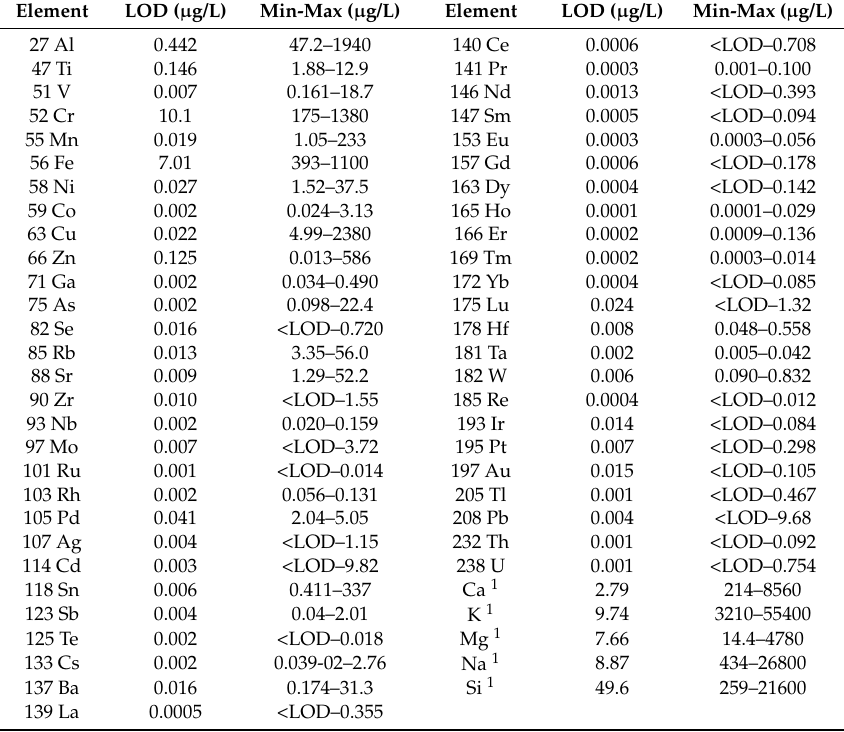
Table 2. Measured elements with limits of detection (LOD), and observed concentration